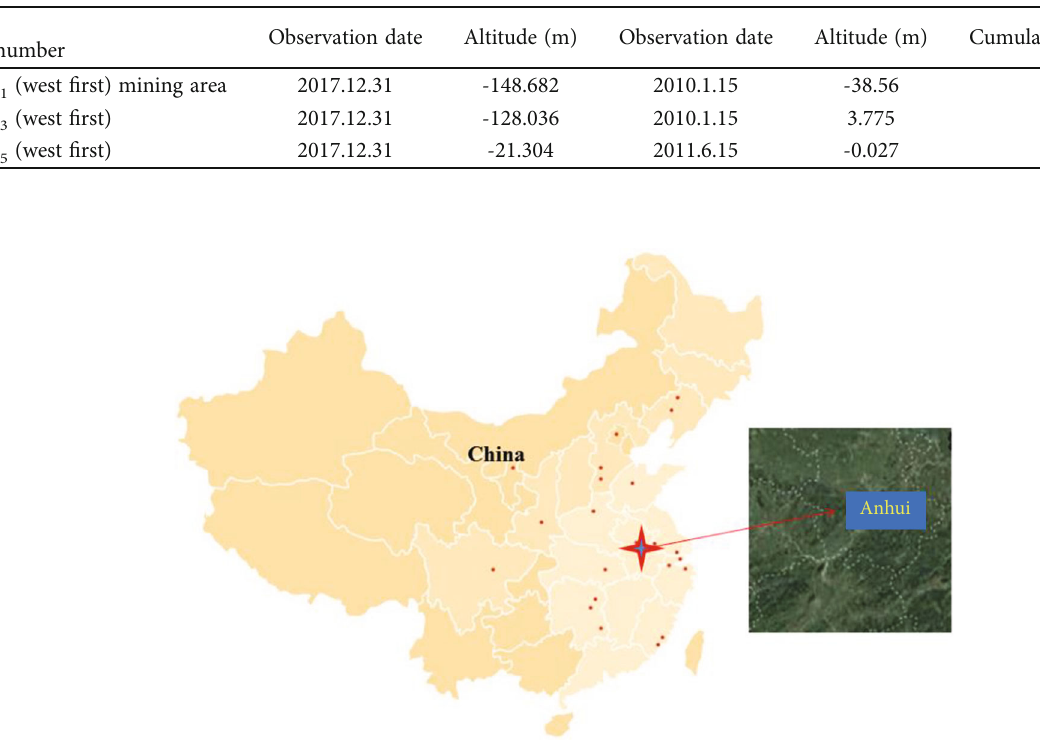
Figure 2: Location of the experimental mine, Anhui,